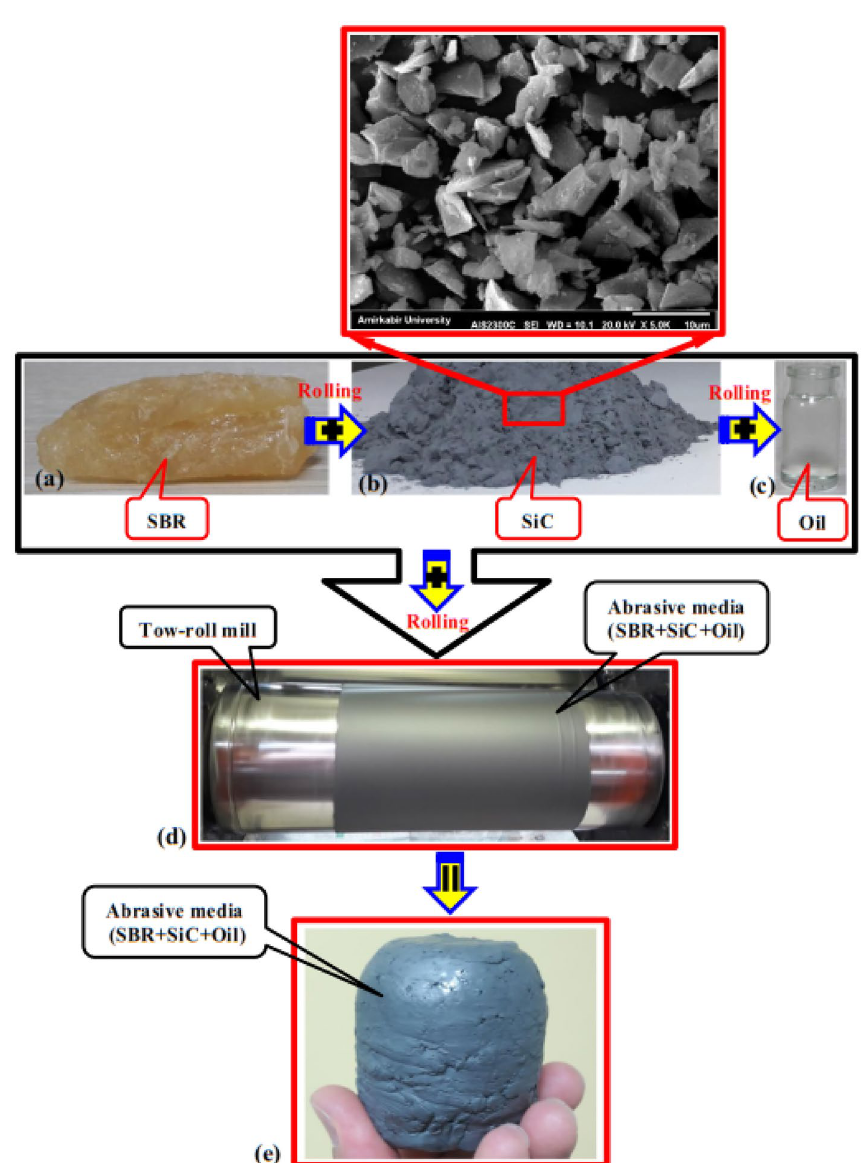
Fig. 3 a – e The fabrication procedure of abrasive media